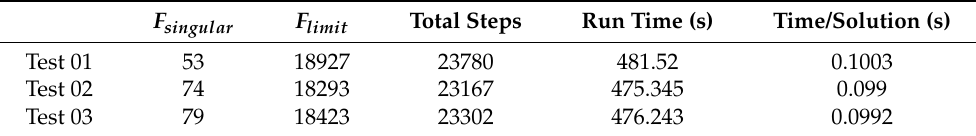
Table 11. Results of NR with random goal poses tests. F singular F limit Total